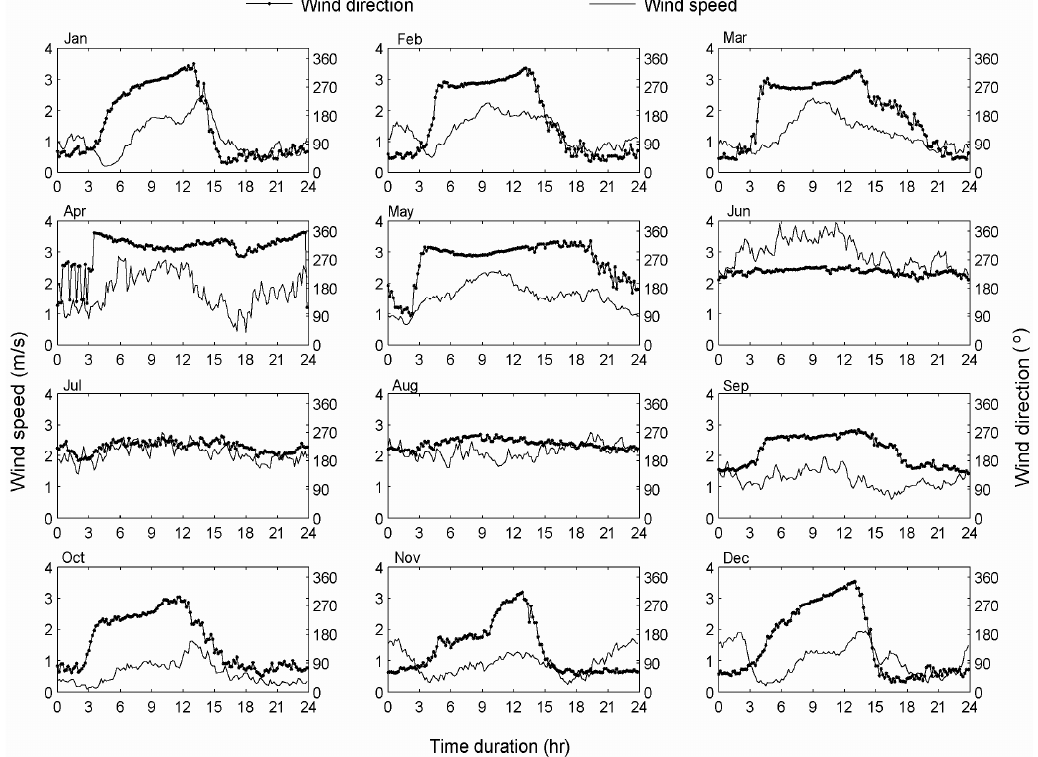
Fig. 4. Hourly variation of wind speed and wind direction during 2011, in Figure 4: Hourly variation of wind speed and wind direction during 2011 in UTC 482